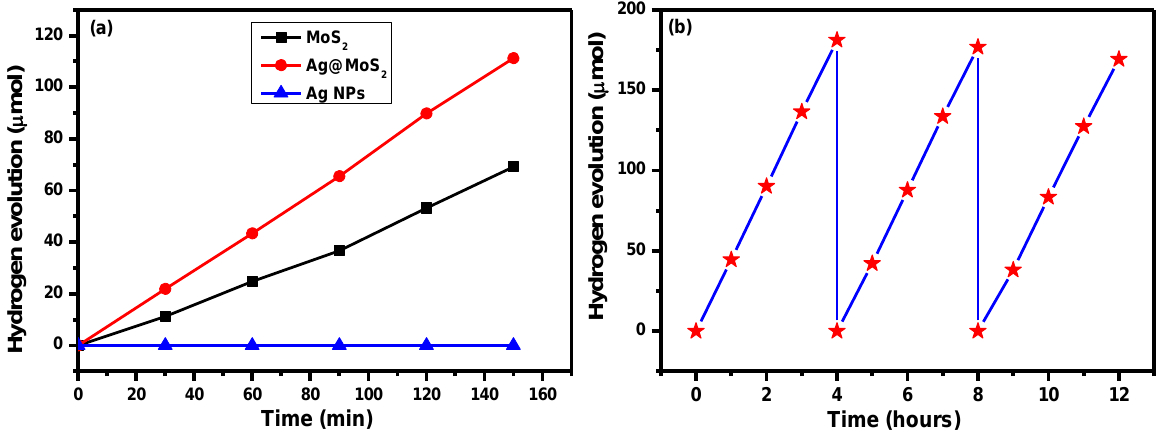
Figure 6. Photocatalytic H 2 production activity using MoS 2 and Ag-MoS 2 composites and Ag NPs: ( a ) cycling tests for photocatalytic H 2 production; ( b ) H 2 evolution in three consecutives for 4 h cycles using Ag-MoS 2 composite. ( (cid:70) indicate the amount of hydrogen produced.)